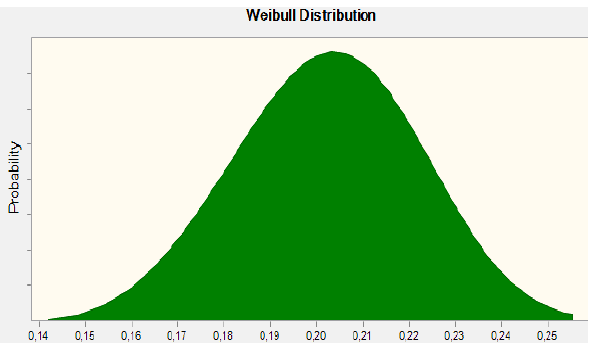
Figure 3. Probability distribution of accommodation facilities’ occupancy in 2003–2019 in the region of Liptov.